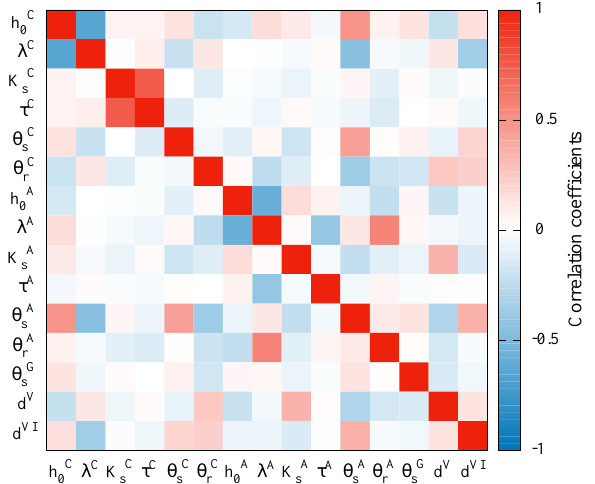
Figure 11. The correlation coefficients for the mean parameter set show in particular that the porosity of the gravel layer ( θ G s ) as well as the position of the material layers ( d V and d VI ) can be reliably estimated from single-offset GPR when evaluating both the signal travel time and